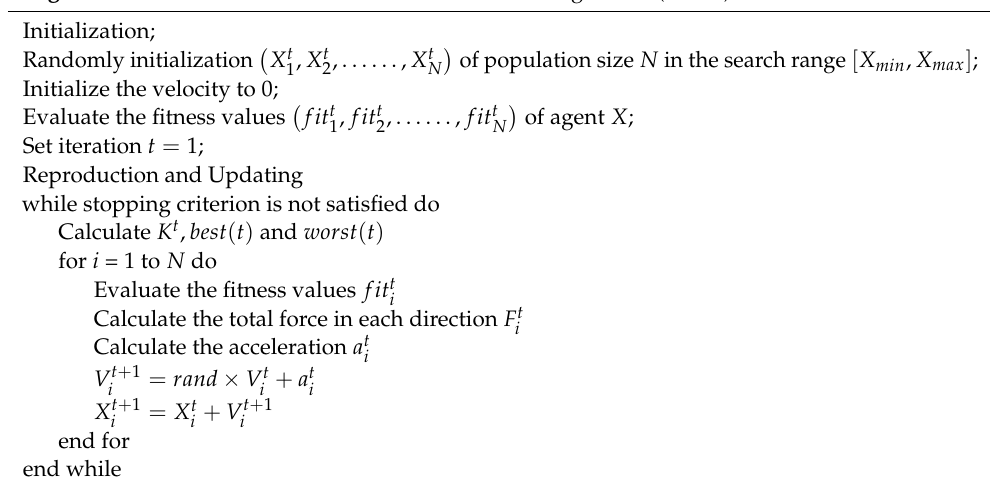
Algorithm 1 Pseudocode of the artificial electric field algorithm